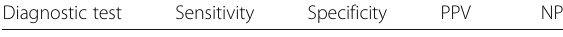
Table 1 The efficiency of synovial LE test compared with the results of synovial fluid culture Diagnostic